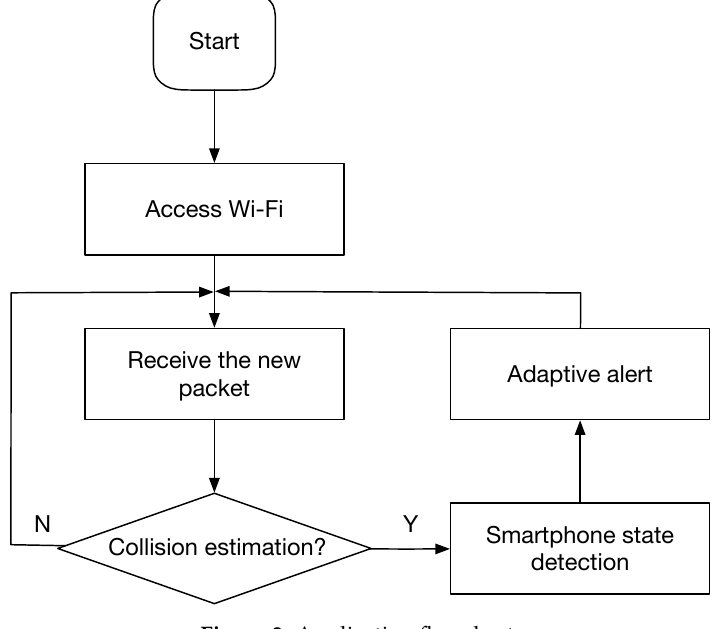
Figure 3. Application